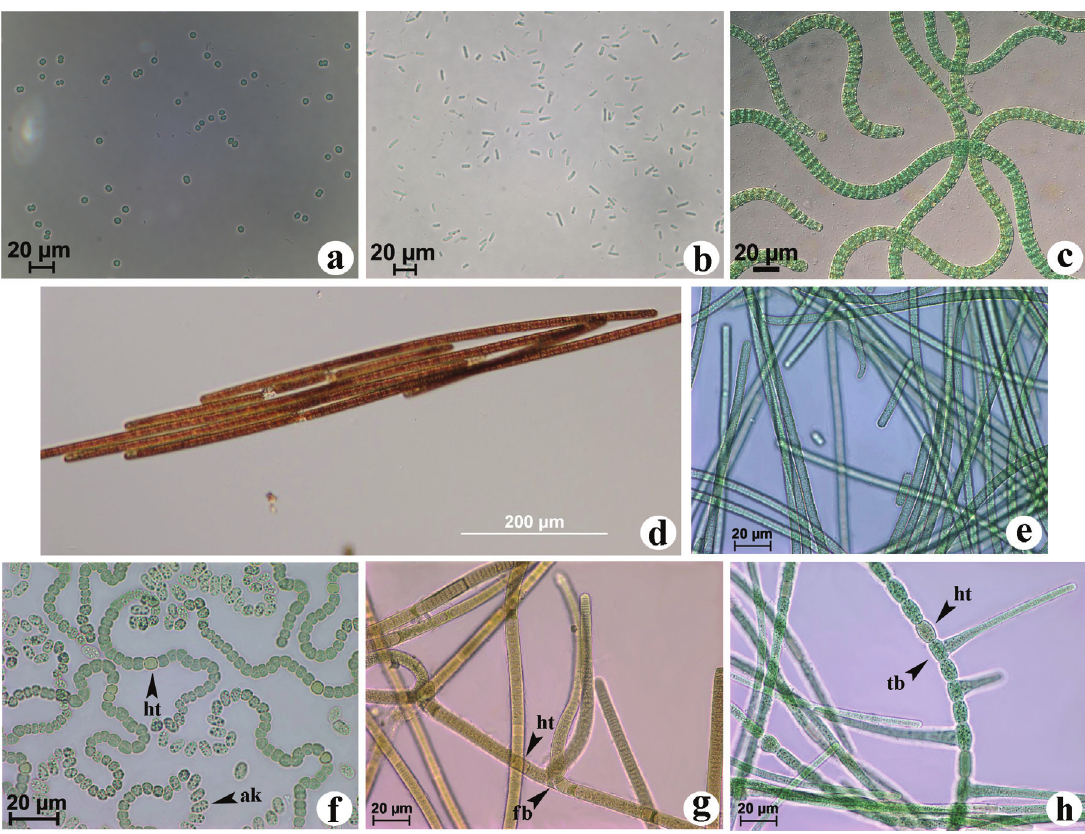
Figure 1 - Natural morphological variation within cyanobacterial genera. Unicellular strains: (a) Synechocystis sp. PCC6803 and (b) Synechococcus elongatus PCC4972. Non-heterocytous strains: (c) Arthrospira maxima, (d) Trichodesmium sp. and (e) Phormidium sp. CCM-UFV034. False branching or non-branching heterocytous strains: (f) Nostoc sp. CCM-UFV028 and (g) Brasilonema octagenarum CCM-UFVE1. True-branching heterocytous strain:(h) Stigonema sp.CCM-UFV036. Synechocystis sp.(a)and Arthrospiramaxima (c)areunabletoperformN 2 fixation,whereasthestrainsshownin b and e present a temporal separation of metabolism: photosynthetic CO 2 fixation is performed in the light while N 2 fixation occurs during darkness. Trichodesmium sp. (d) is the unique non-heterocytous cyanobacterium that shown N 2 fixation under light conditions. Conversely, in other strains (f, g, and h), there is a spatial separation of metabolism, with N 2 fixation occurring in heterocytes (ht). Abbreviations: (ak) akinetes; (fb) false branching; (tb) true branching. The picture of Arthrospira maxima (c) was kindly provided by the Culture Collection of Autotrophic Organisms (CCALA), http://ccala.butbn.cas.cz and the picture of Trichodesmium sp. (d) by Prof. Ondøej Práil, Institute of Microbiology, Czech Academy of Sciences, Czech Republic. The other pictures are from strains kept at Collection of Cyanobacteria and Microalgae from Universidade Federal de Viçosa